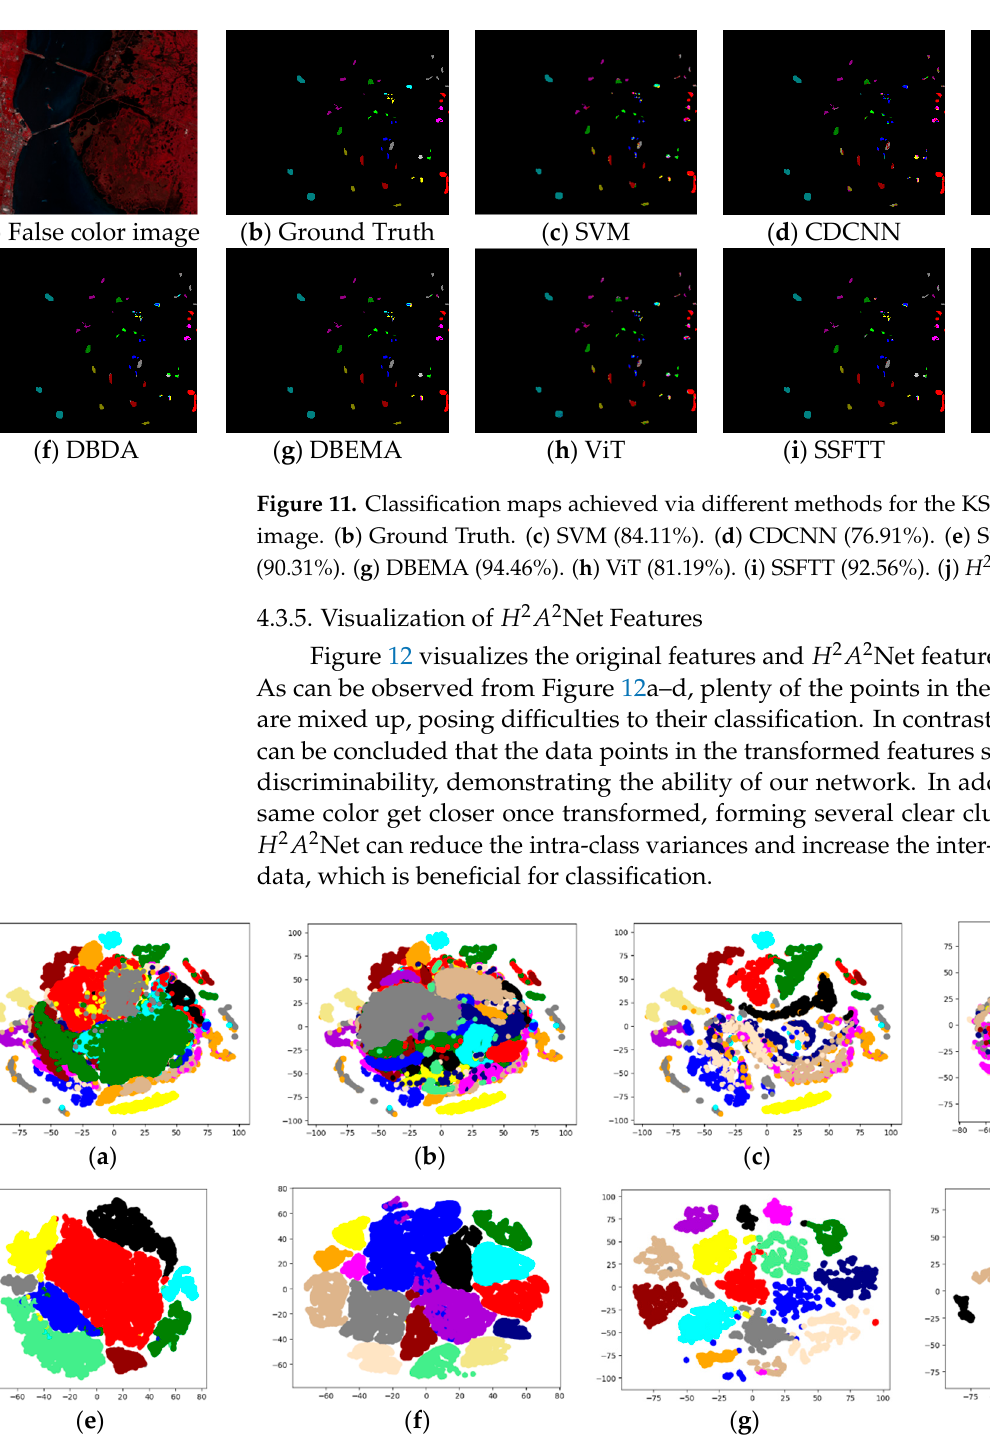
Figure 12. Two-dimensional t-SNE [66] visualization of features obtained by H 2 A 2 Net. ( a – d ) Original features of UP, SV, HOU and KSC datasets, respectively. ( e – h ) Transformed features of UP, SV, HOU, and KSC datasets, respectively. Different colors correspond to different classes.